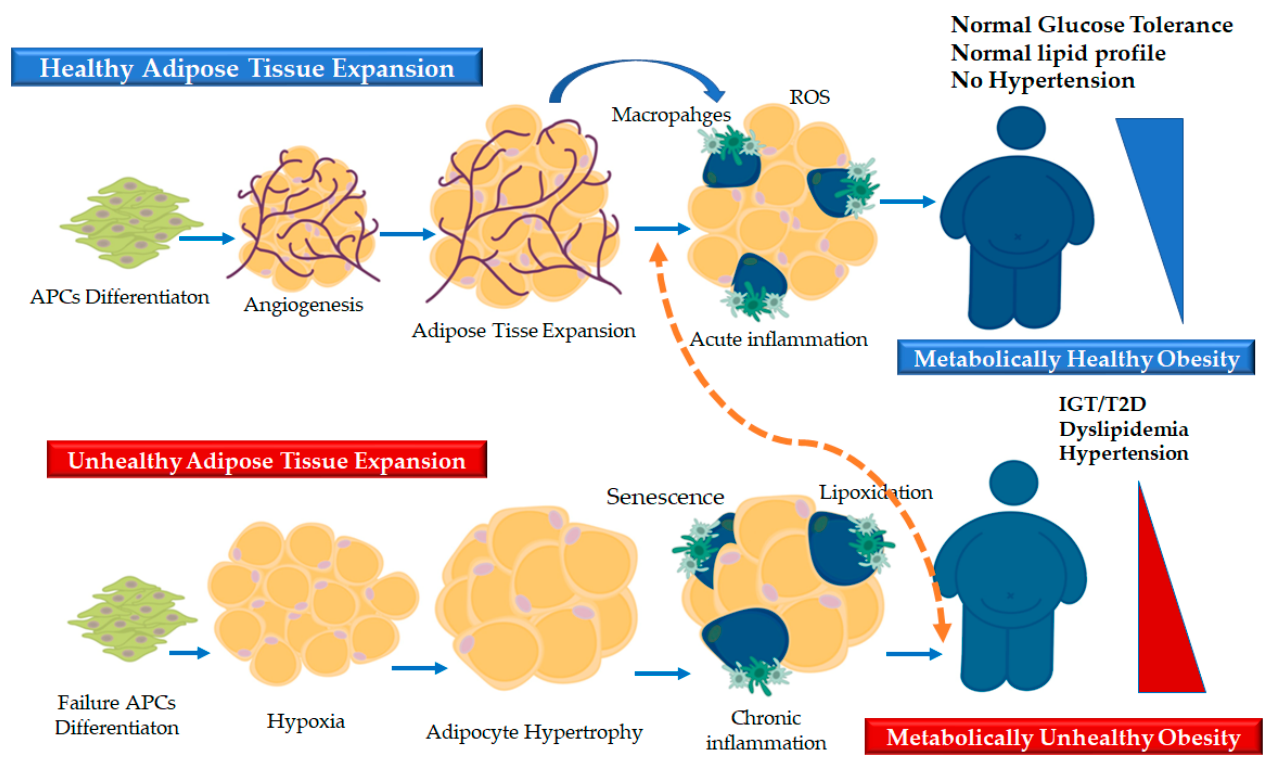
Figure 1. Adipose organ plasticity. “Healthy” or “unhealthy” signatures of fat expansion and oc ‐ currence of “metabolically healthy” or ‘‘unhealthy’’ obese sub ‐ phenotypes. The “healthy” or “un ‐ healthy” signatures of fat may be interchangeable over time (dashed arrow).